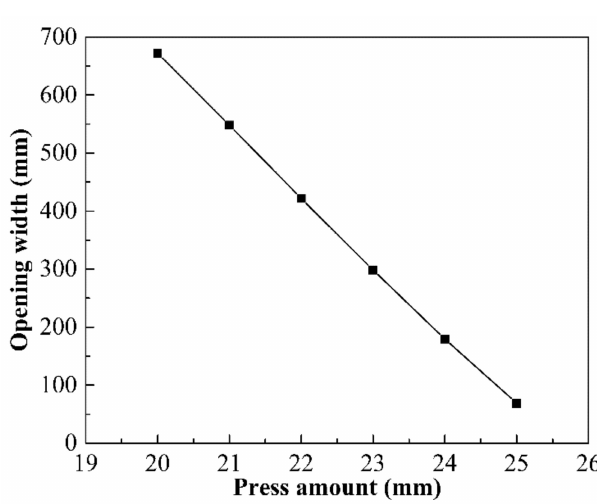
Figure 10. Pipe billet after “O” forming.